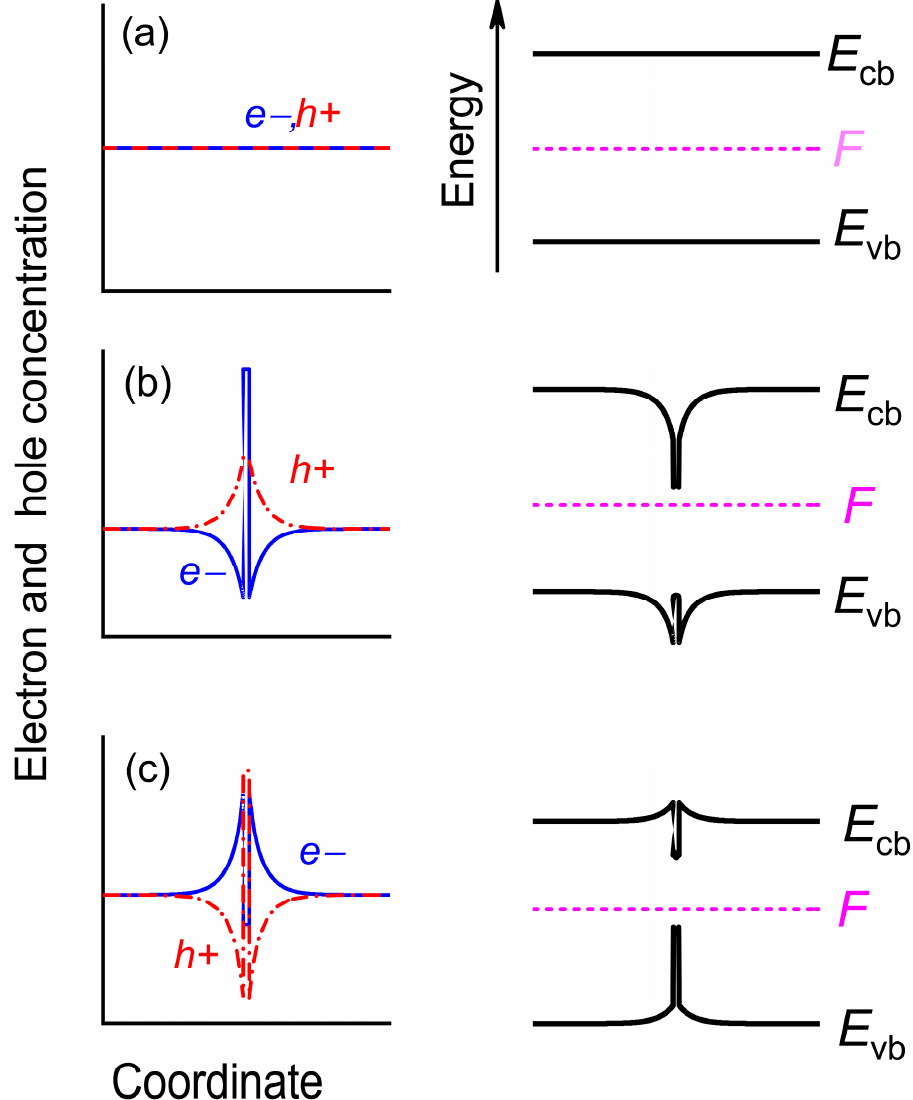
Figure 5. Schematic band diagrams and spatial electron e − and hole h+ distributions. ( a ) Bulk material, ( b ) QW with Fermi level shifted toward the conduction band, ( c ) QW with the Fermi level shifted toward the valence band.